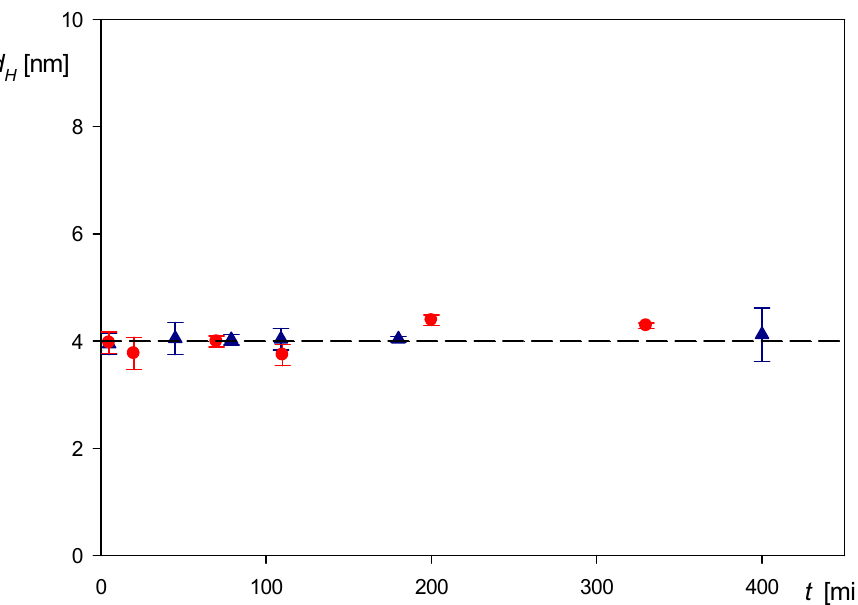
Figure 1. Dependence of the myoglobin hydrodynamic diameter on the storage time derived applying DLS measurements for NaCl concentration of 0.01 M; 1. • pH 3.5, 2. (cid:78) pH 7.4 (PBS), and NaCl concentration 0.15 M. The dashed line shows the initial value of the hydrodynamic diameter equal to 4.1 nm.